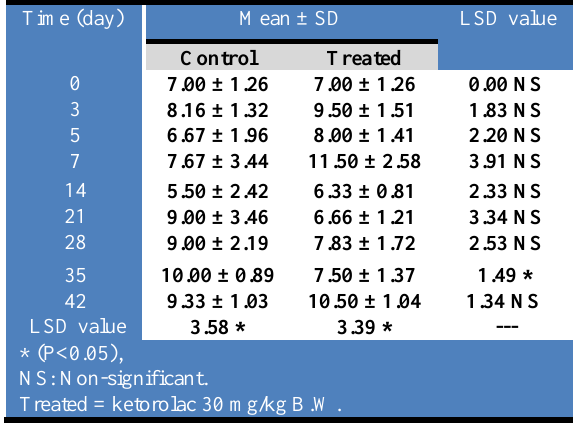
Table, 11: Shows Monocytes (%) in control and ketorolac treated rabbits..